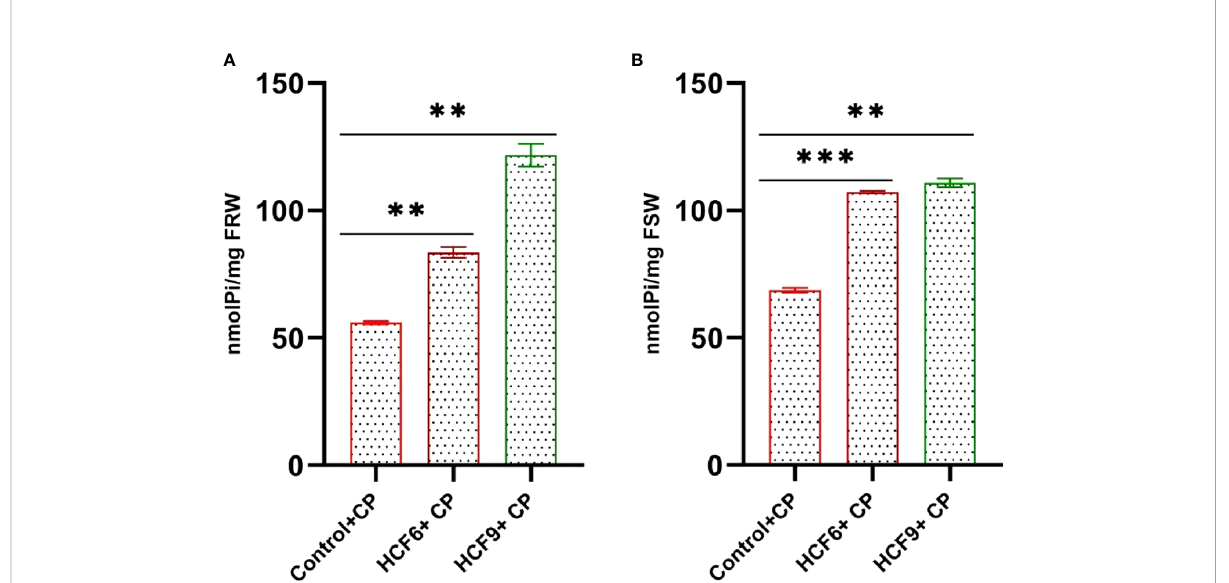
FIGURE 4 Quanti fi cation of inorganic phosphate (Pi) content in the root and shoot tissue of wheat plant grown in Ca 3 (PO 4 ) 2 -mixed sand medium (CP). (A) Total soluble Pi content (nmolPi/mg) per mg of fresh root weight (FRW). (B) Total soluble Pi content (nmolPi/mg) per mg of fresh shoot weight (FSW). Data are reported as mean values ( n =6 ± SE) of two independent experiments. ***P < 0.001; **P <